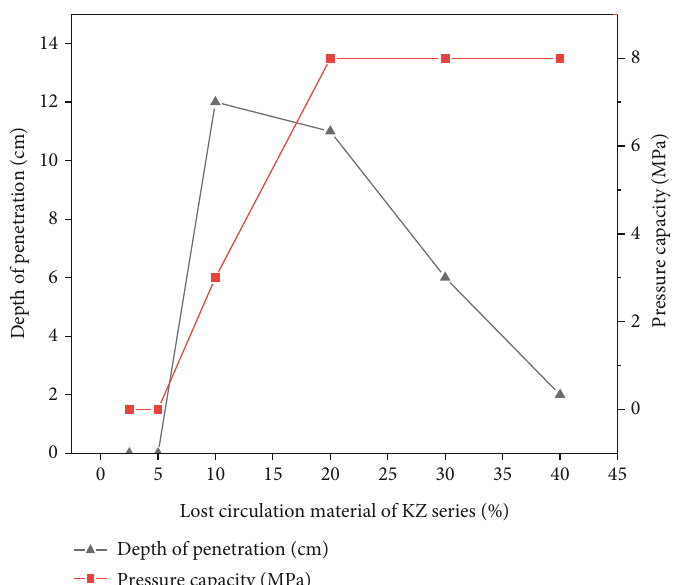
Figure 7: The e ff ect of the concentration of the plugging material on the pressure-bearing capacity and invasion depth of the plugging layer.